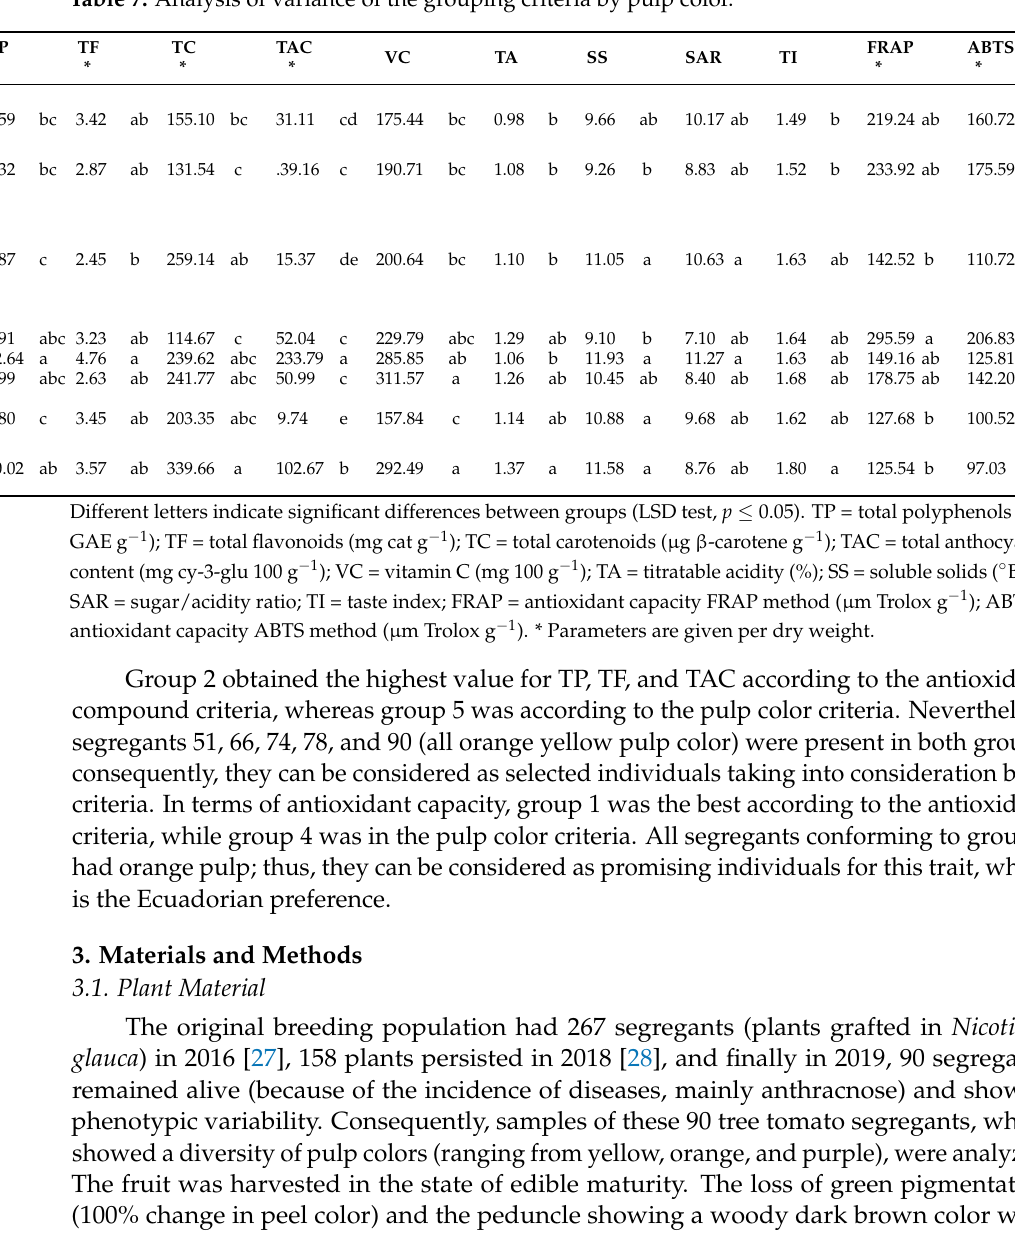
Table 7. Analysis of variance of the grouping criteria by pulp color.